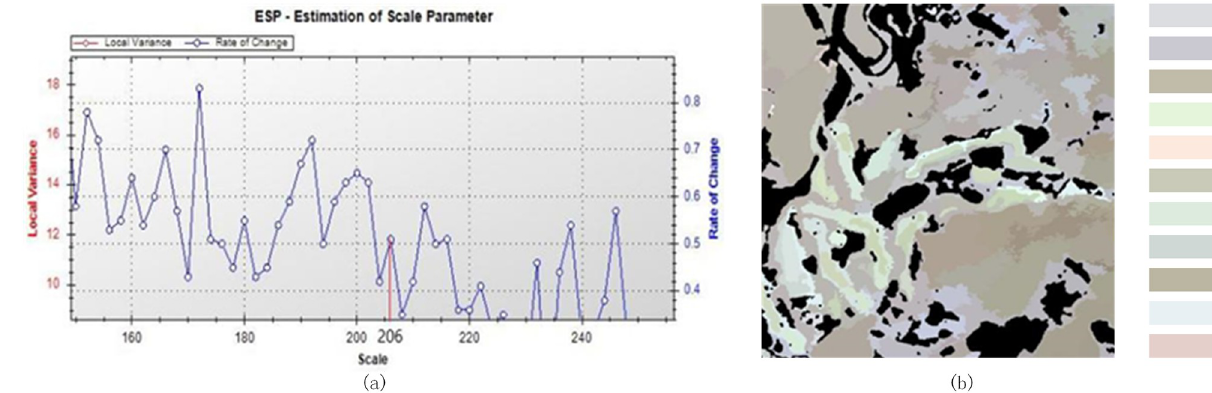
Fig 6. Multiresolution segmentation (SS = 206, WS_1 = 0.5, WC = 0.7): (a) variance curve and (b) image object.